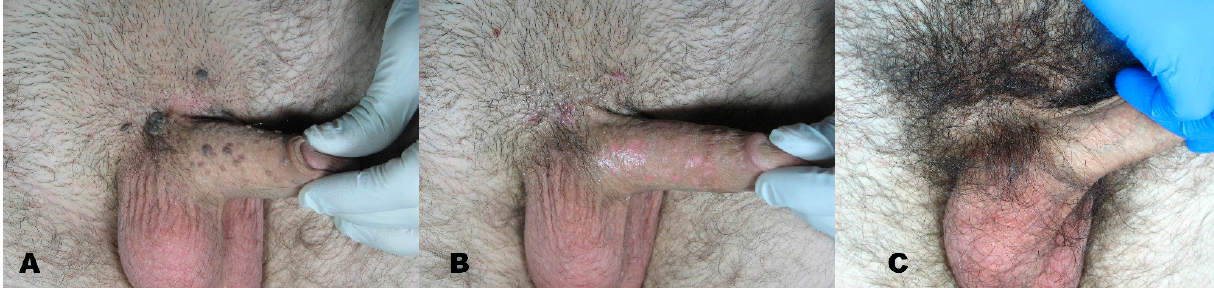
Figure 8. ( A ) Facial flat warts before treatment. ( B ) Region after removal with Erbium laser.